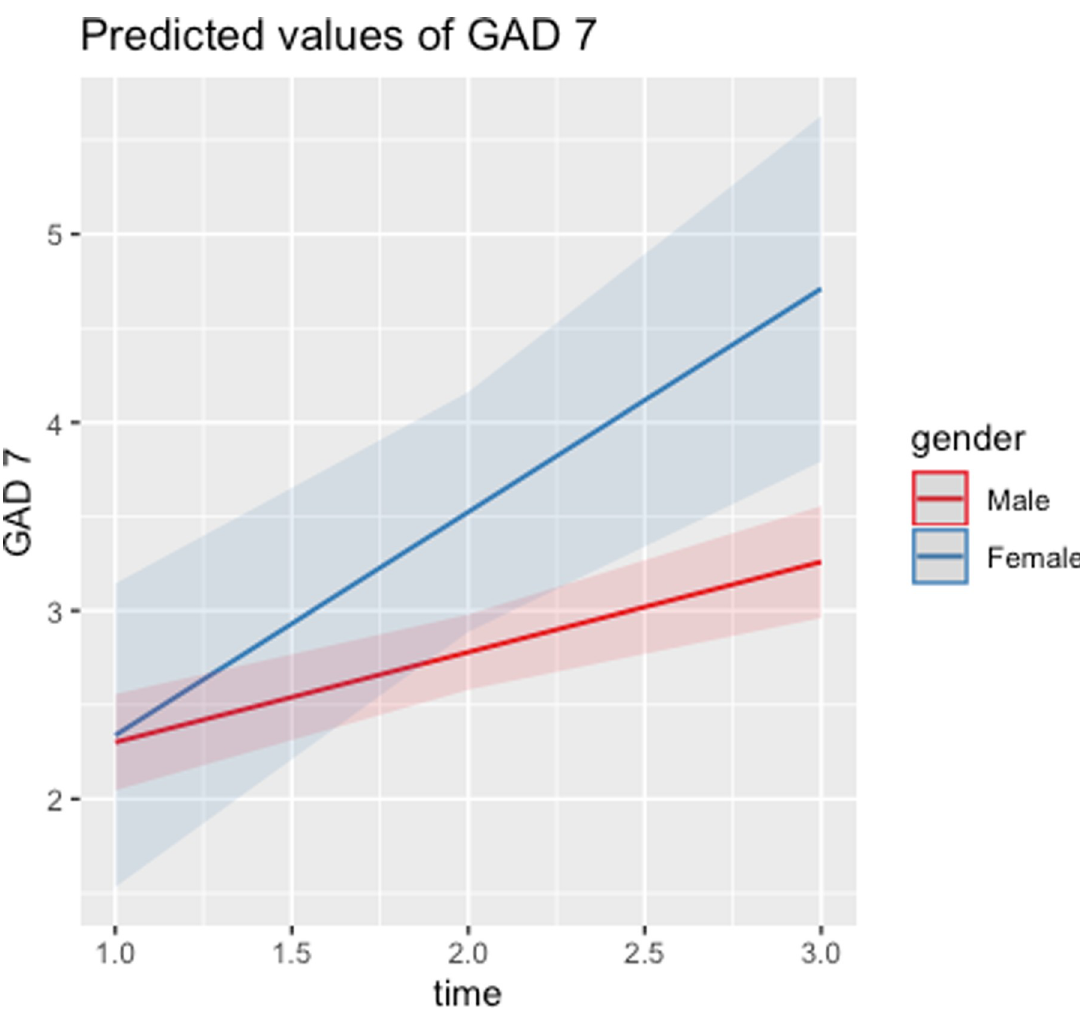
Fig 3. Predicted values of GAD-7 across time: Males vs.